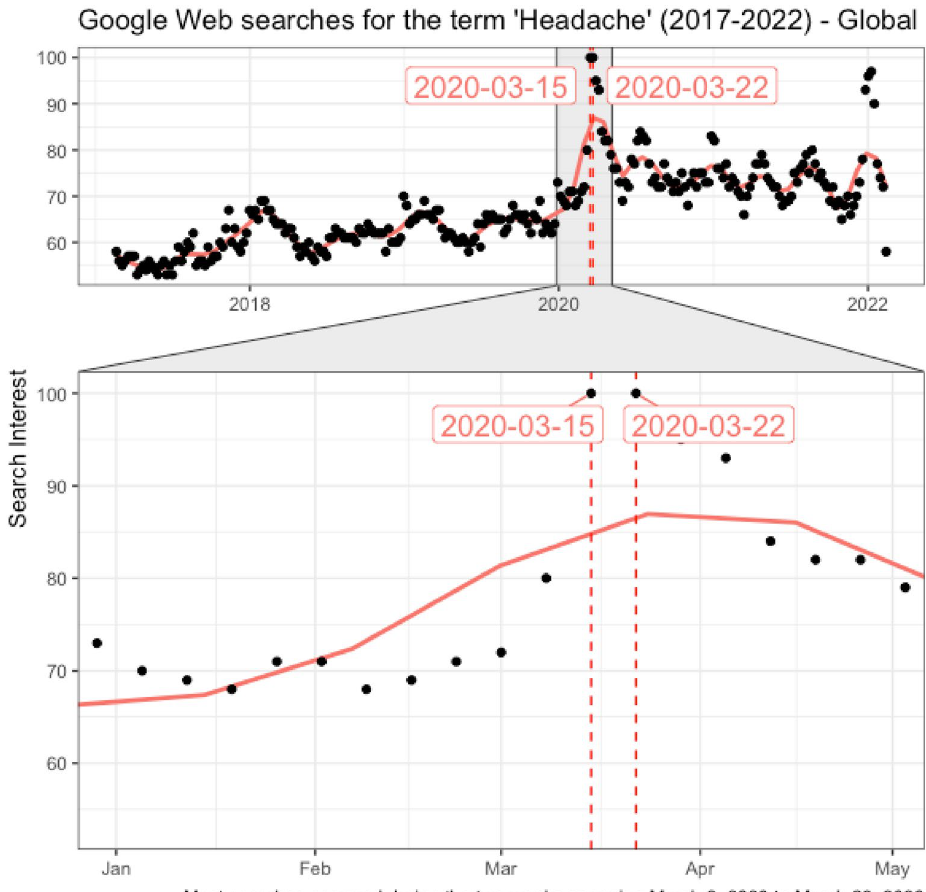
Figure 1. Search volume index for the keyword “headache” (February 2017–February 2022, worldwide) (above); zoom in at the period spanning January to May 2020 (below), reflecting the peak popularity of the term reached on the second and third weeks in March